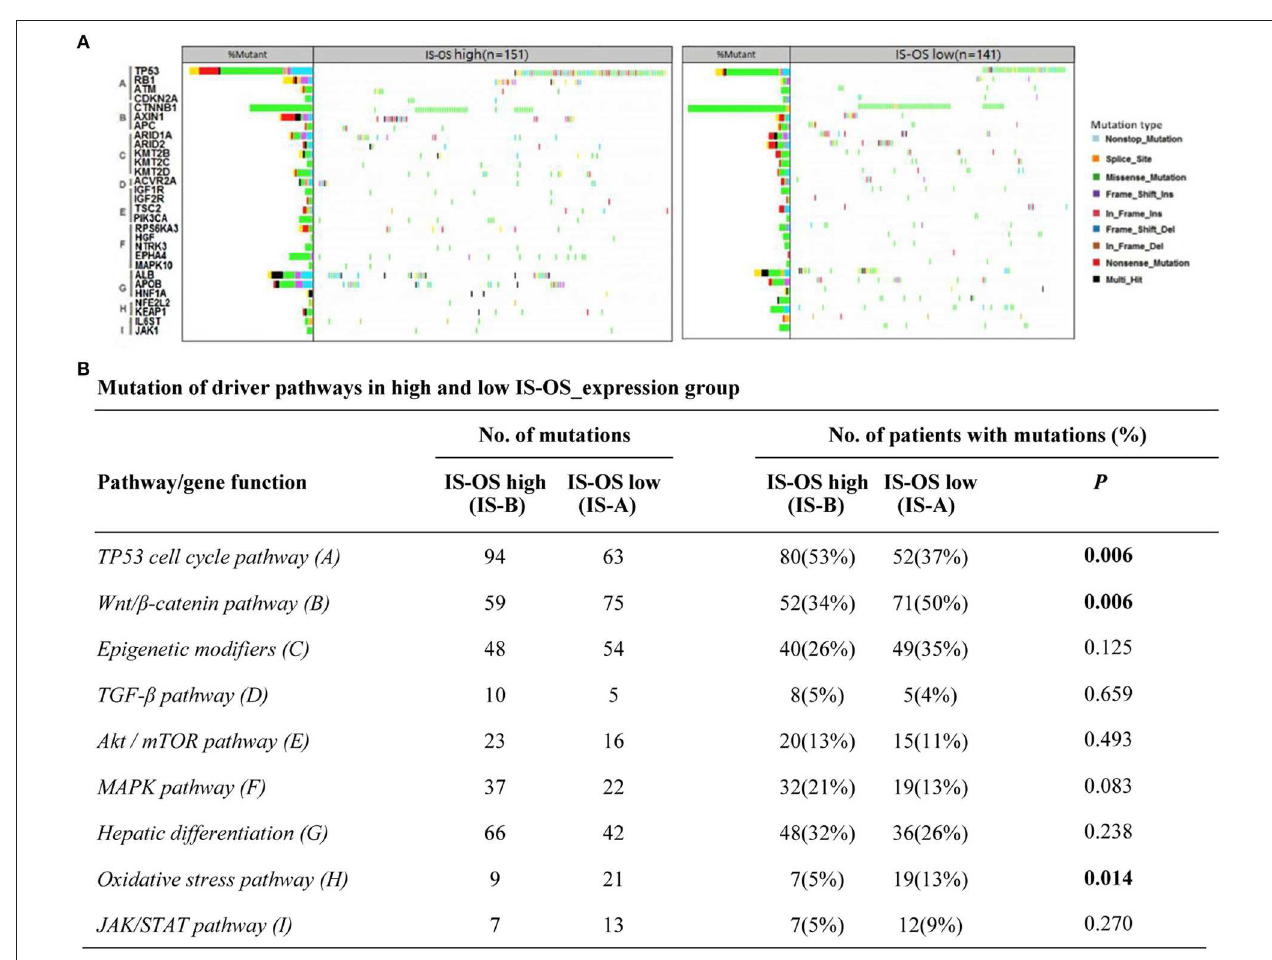
FIGURE 6 | Pathway-based gene mutations in IS-A and IS-B samples (overall survival). (A) Waterfall plot of mutated genes in IS-A and IS-B samples. Gene mutations were ordered by distinct pathways: A indicates the TP53 cell cycle pathway; B, the Wnt/ β -catenin pathway; C, epigenetic modifiers; D, TGF- β signaling; E, the Akt/mTOR pathway; F, the MAPK pathway; G, hepatic differentiation; H, the oxidative stress pathway; and I, JAK/STAT signaling. Each column represents a sample. Boxes with different colors indicate different types of non-synonymous mutations. (B) Numbers of mutations and numbers of patients with or without mutations in IS-A and IS-B